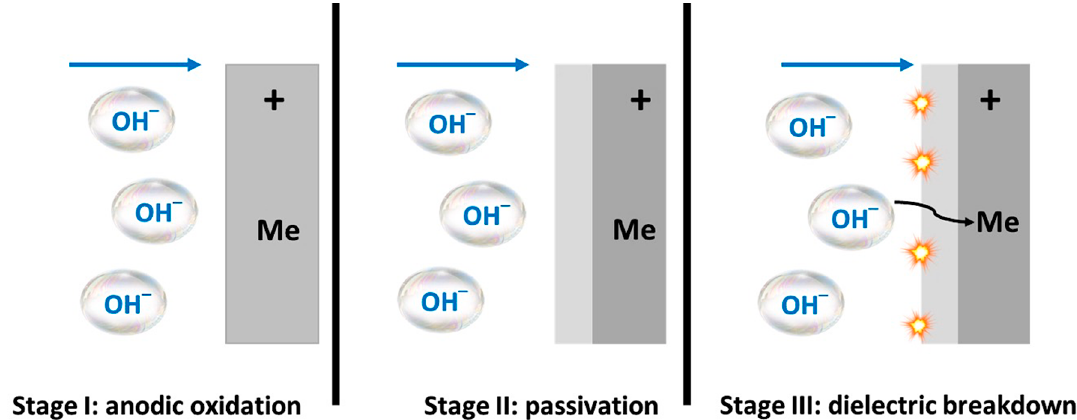
Figure 4. A schematic diagram explaining primary stages of an oxide layer generation in anodizing and PEO process. Adapted from [38]. Copyright IntechOpen, 2012.